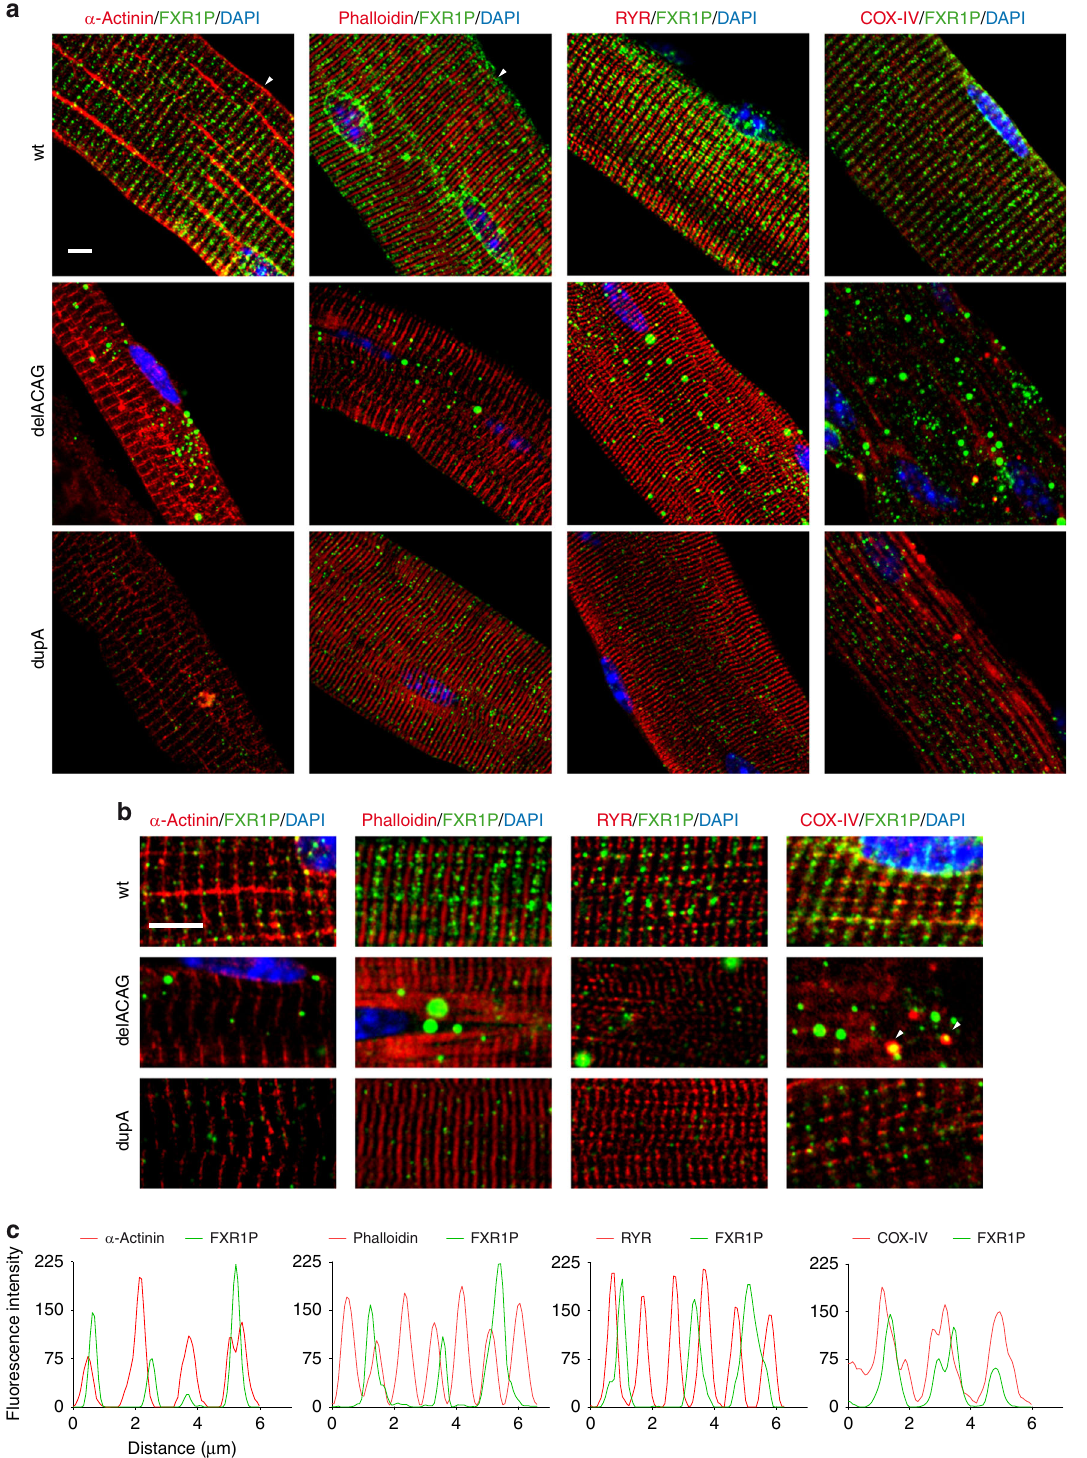
Fig. 6 Co-localization analysis of P82,84 isoforms in EDL fi bers. a , b Maximum Z-projects ( a ) and single slice from Z-stack ( b ) corresponding to confocal overlay images of double-immuno fl uorescence labeling for FXR1P (green) and α -actinin, phalloidin, RYR and COX-IV (red) in isolated EDL fi bers from different mice. Scale bars 5 µ m. Arrowheads in panel a point to Z-lines, and in panel b (delACAG COX-IV/FXR1P image) indicate co-localization of FXR1P granules and mitochondria. Nuclei are stained with DAPI (blue). c Representative RGB intensity pro fi le along a line corresponding to a Z-stack slice of a wt EDL fi ber showing co-localization results between FXR1P (green) and sarcomeric markers (red). FXR1P is adjacent to Z-lines and mitochondria. Experiments were performed in n = 3 mice except for RYR ( n = 2 mice). For each mouse several fi bers were analyzed in each